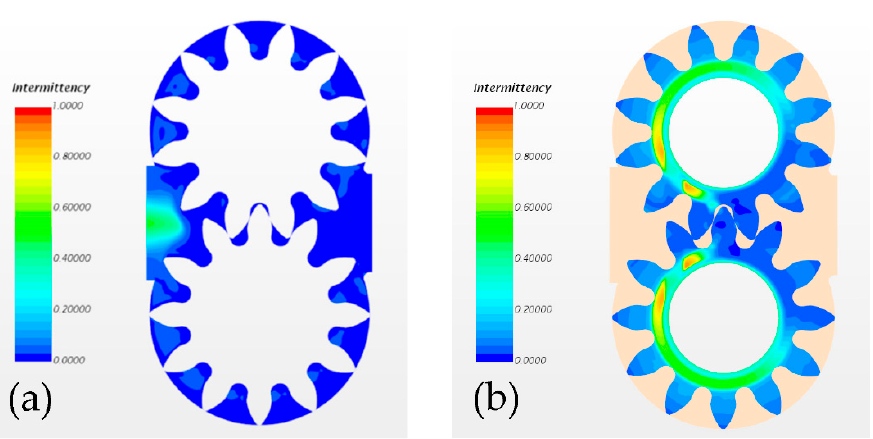
Figure 16. Intermittency colored maps: ( a ) Intermittency along the flow transfer section; ( b ) intermittency within the axial leakage. The background and overset regions are highlighted in beige.